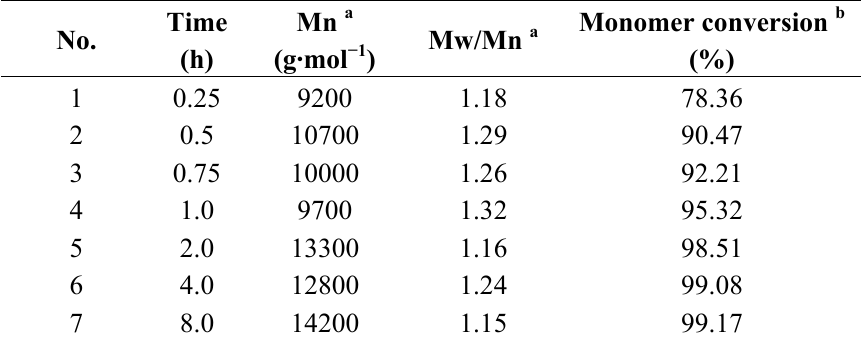
Table 2. Effects of the Reaction Time on the Polymerization of Lac-OCA.